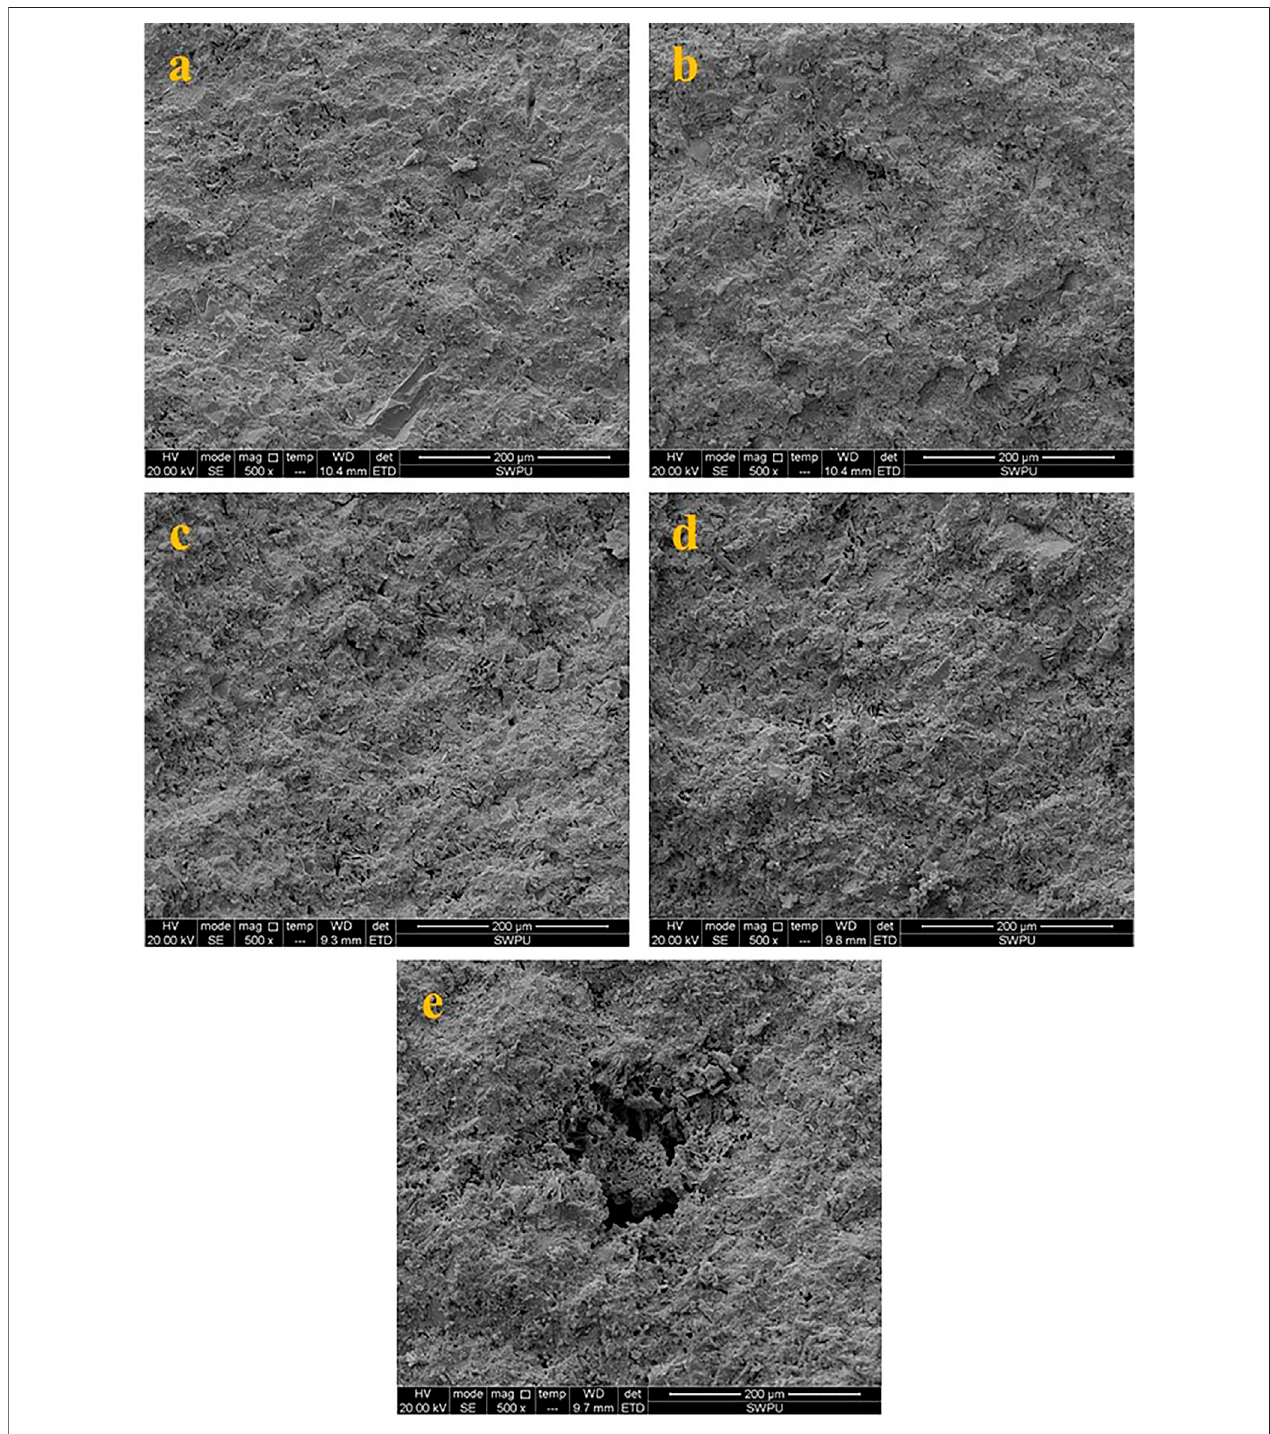
FIGURE 12 | Surface micro morphology of the C1 cement paste cured at different temperatures ( a : 50 ° C; b : 300 ° C; c : 400 ° C; d : 500 ° C; e : 600 ° C).